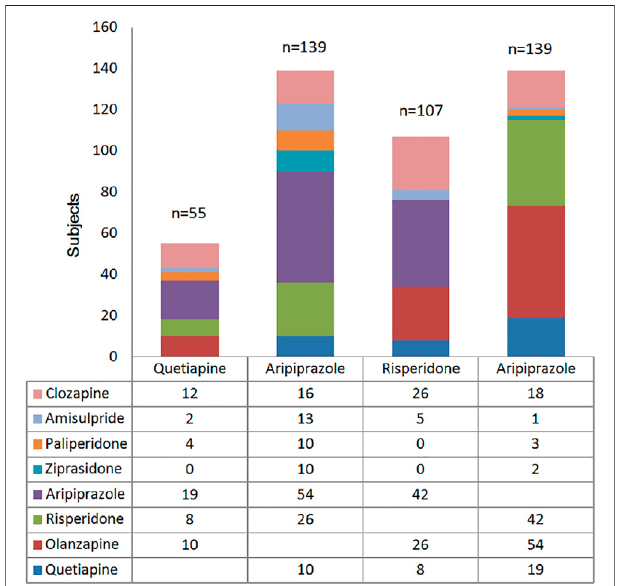
FIGURE 2 | Analysis of Polypharmacy of antipsychotic.